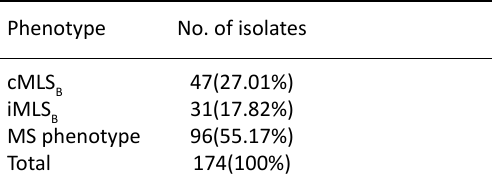
Fig. 2. Showing MRSA & MSSA Table 2. Showing different S.aureus phenotypes Table 3. Showing phenotypes among MRSA and MSSA